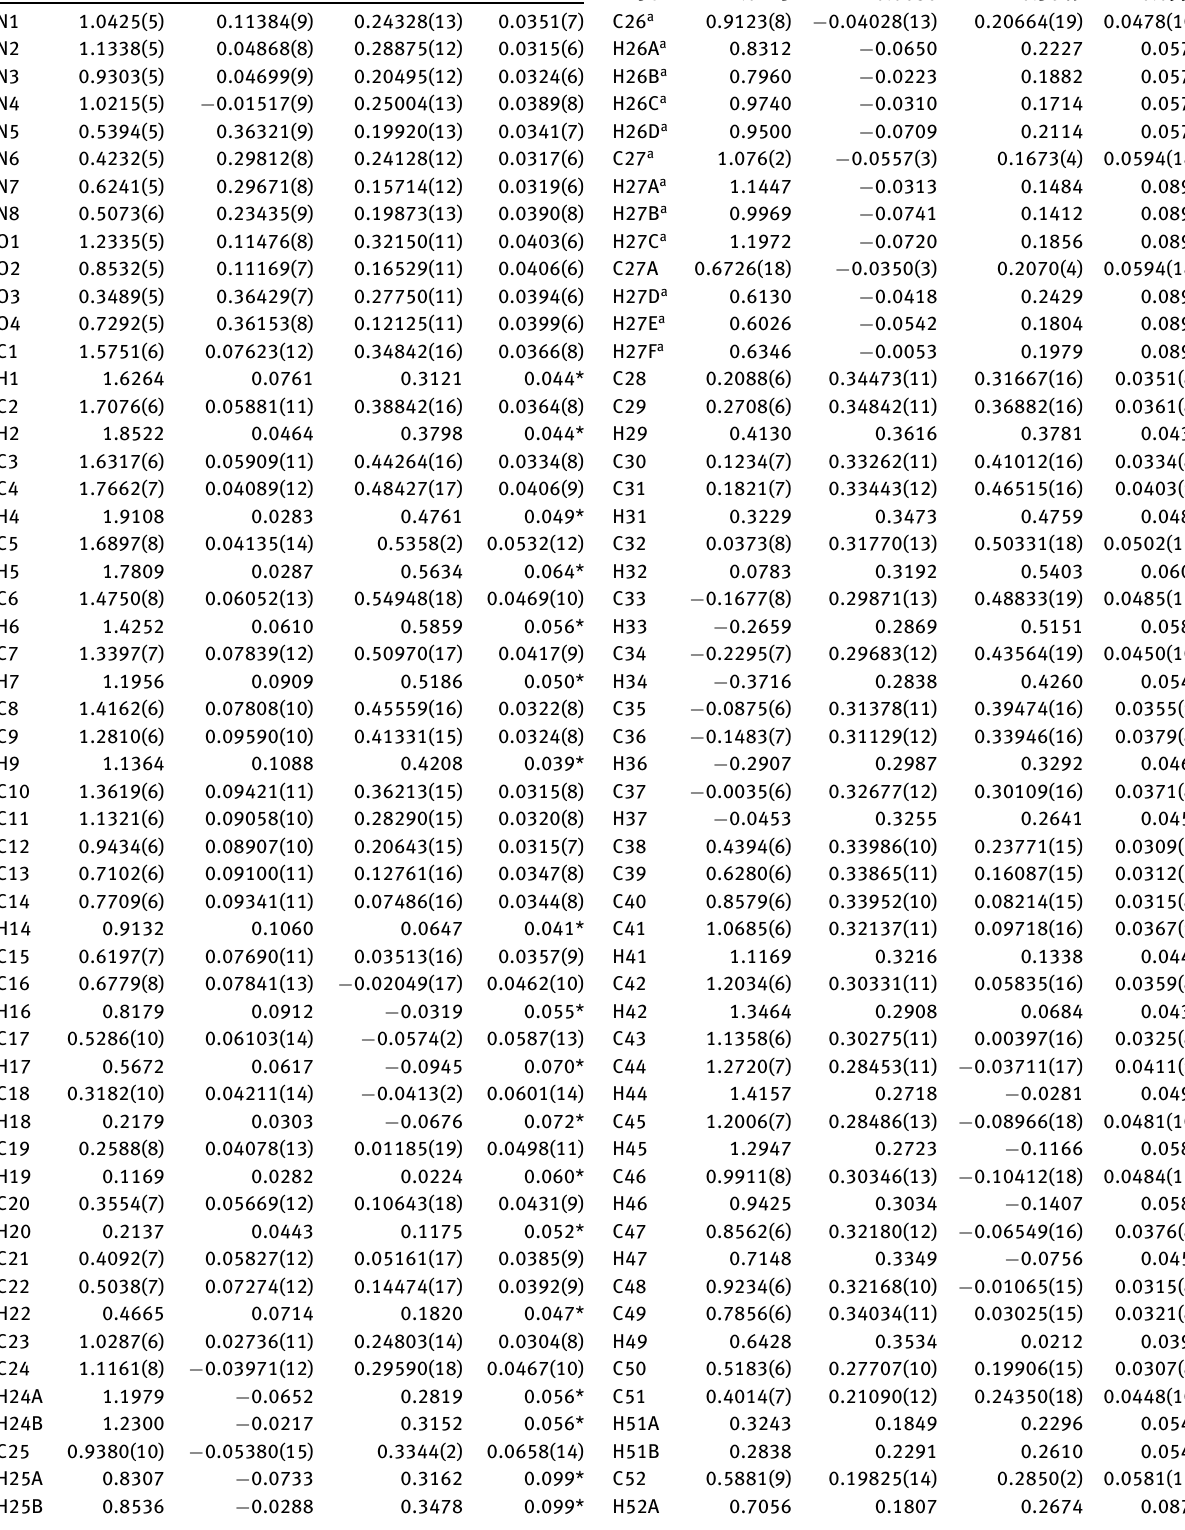
Table 2: Fractional atomic coordinates and isotropic or equivalent isotropic displacement parameters (Å 2